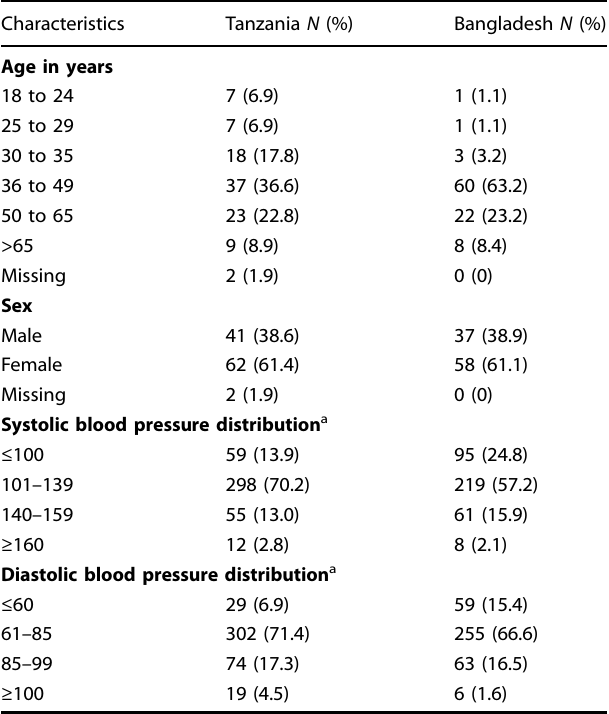
Table 2. Characteristics of general population participants — Tanzania ( N = 103; M = 424) and Bangladesh ( N = 95; M =